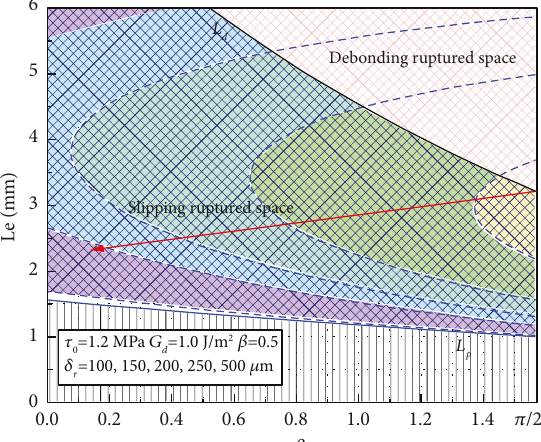
Figure 9: Growth of the slipping rupture space during crack propagation.